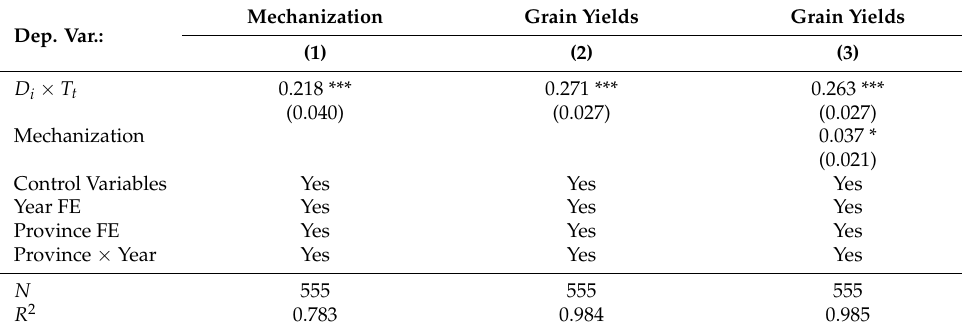
Table 12. Channel 2—improving mechanization.